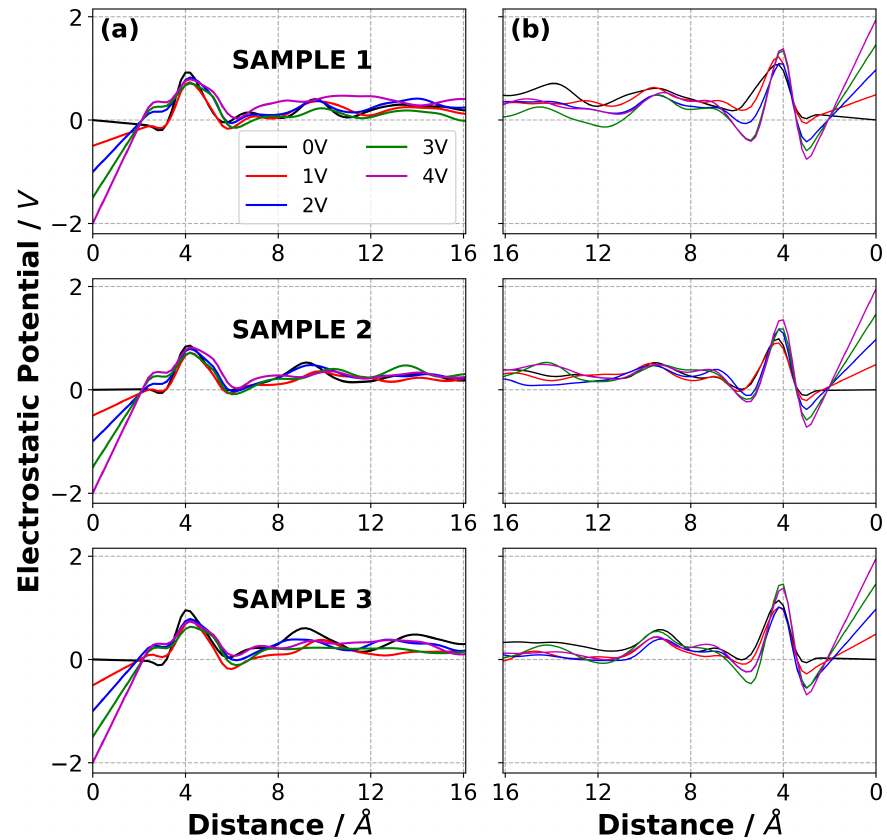
Figure 11. Electrostatic potential profile as a function of ∆Ψ for [N 4,1,1,1 ][NTf 2 ] system on the ( a ) negative electrode and ( b ) positive electrode, for each sample at 294 K. The distance of zero corresponds to the electrode surface. The three samples were simulated under identical conditions but with different initial configurations. They give an indication of the robustness of the results.